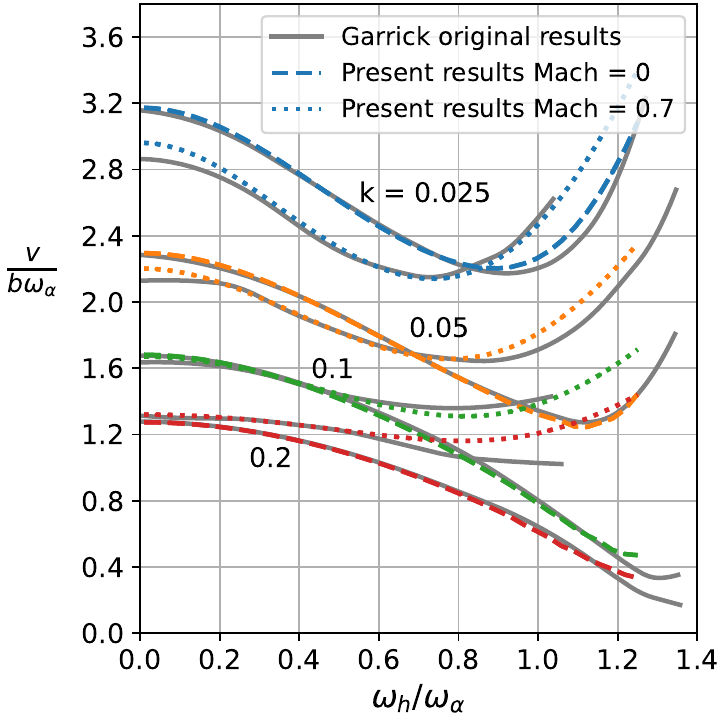
Figure 7. Flutter speed as a function of frequency ratio for an airfoil with elastic axis at Λ 1 = −